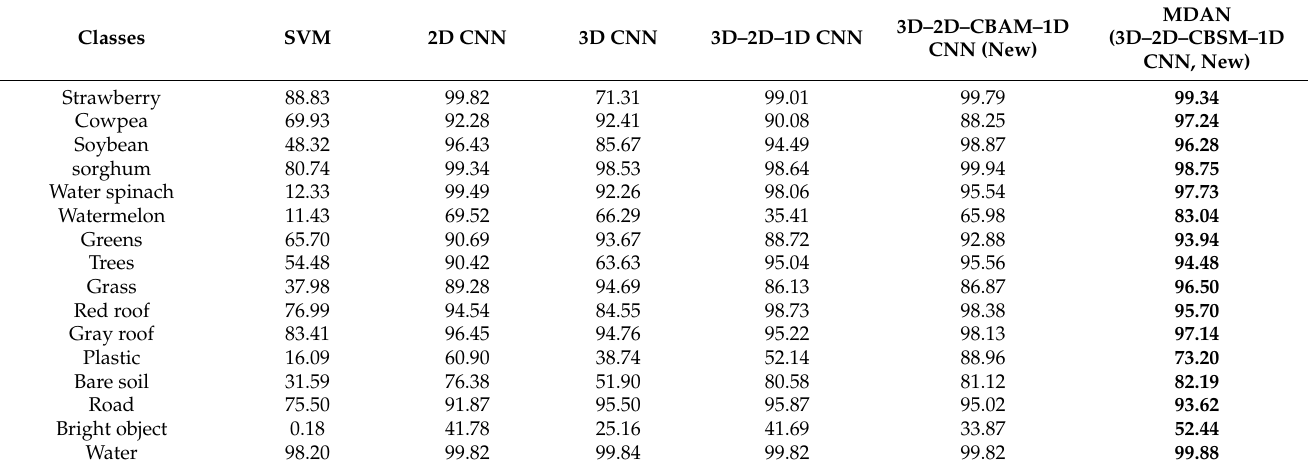
Table 7. Classification accuracies of the WHU dataset. This table shows the best performances in